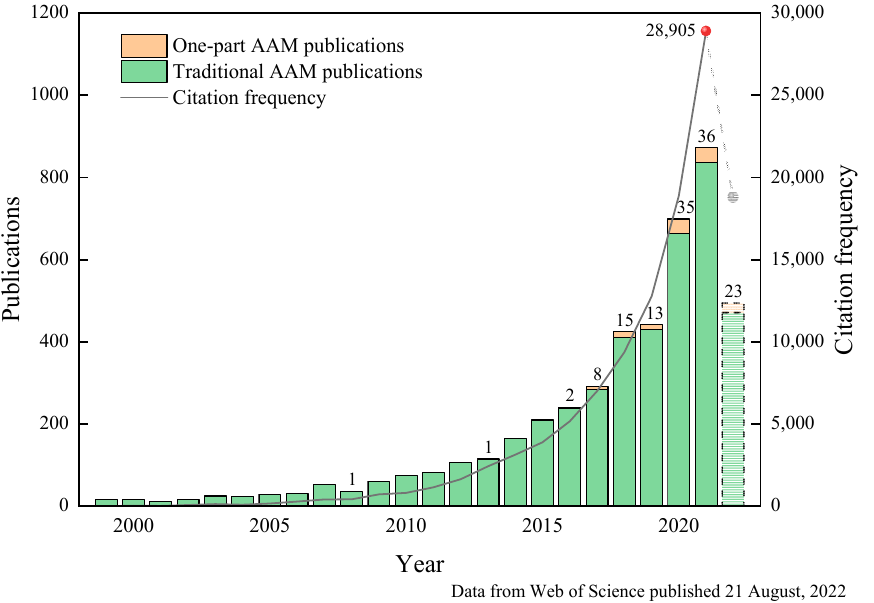
Figure 1. Publication and citation frequency statistics of traditional AAM and one-part AAM during 1999–2022.